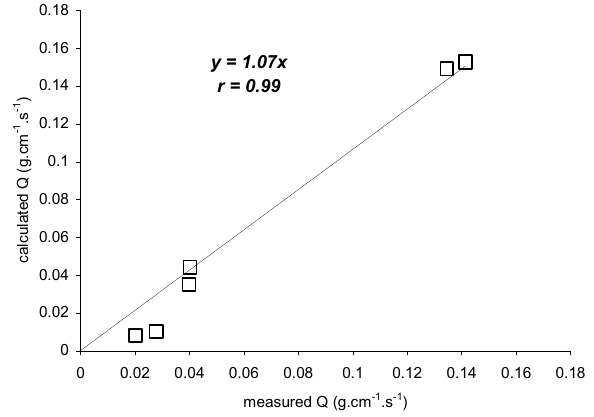
FIGURE 11 Fig. 11. Total flux reduction relative to an unridged surface for various ridged surfaces as a function of the wind velocity.